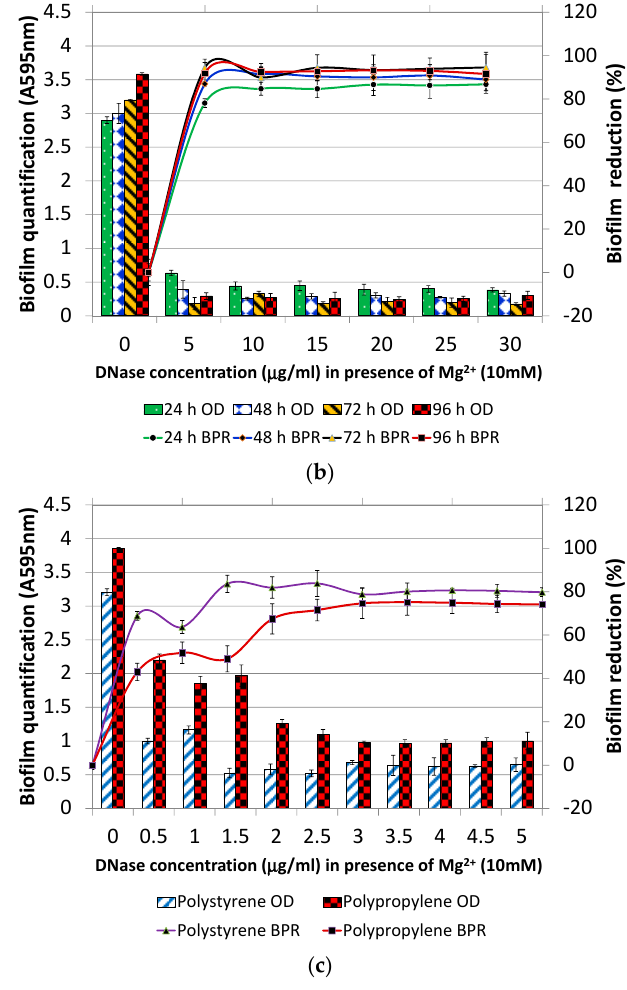
Figure 2. Effect of variable time of post-treatment on 24, 48, 72, 96 h old P. aeruginosa PAO1 biofilm with ( a ) DNase (10 µg/mL; without Mg 2+ ) and for varying contact time; ( b ) DNase (10 µg/mL) in the presence of Mg 2+ (10 mM) and for contact time of 15 min; ( c ) variable DNase (µg/mL) in the presence of Mg 2+ (10 mM) and for contact time of 15 min.